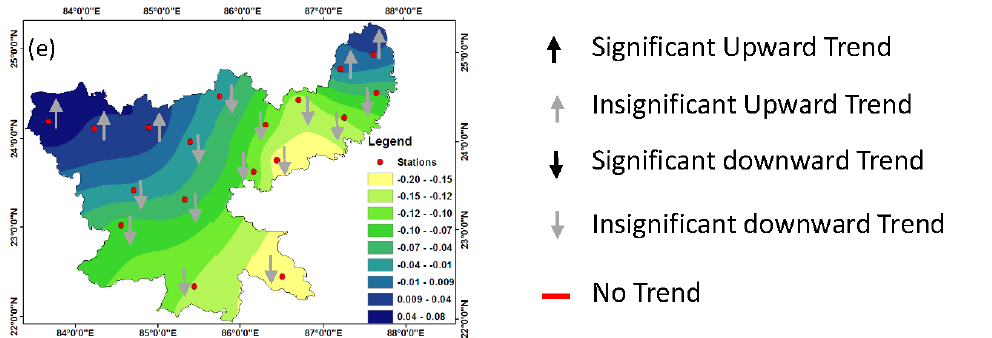
Figure 5. Spatial distribution of Sen’s slope value and trend direction (Mann Kendall statistics) from 1901–1951of ( a ) Annual; ( b ) Monsoon; ( c ) Pre-monsoon; ( d ) Post-monsoon and ( e ) Winter season. Climate 2017 , 5 , 18